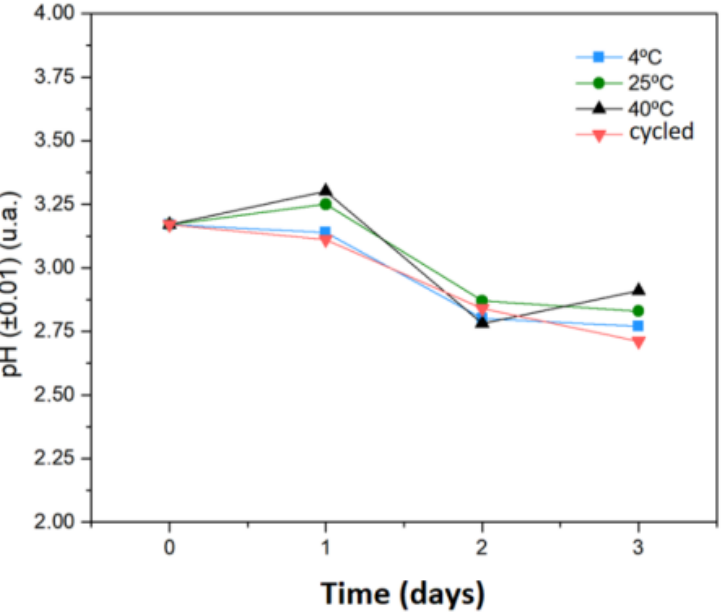
Figure 7. Forced stability of 5-ALA in aqueous medium for 4 days at 4 °C, 25 °C, 40 °C and cycled (24 h at 4 °C and 24 h at 40 °C) conditions.